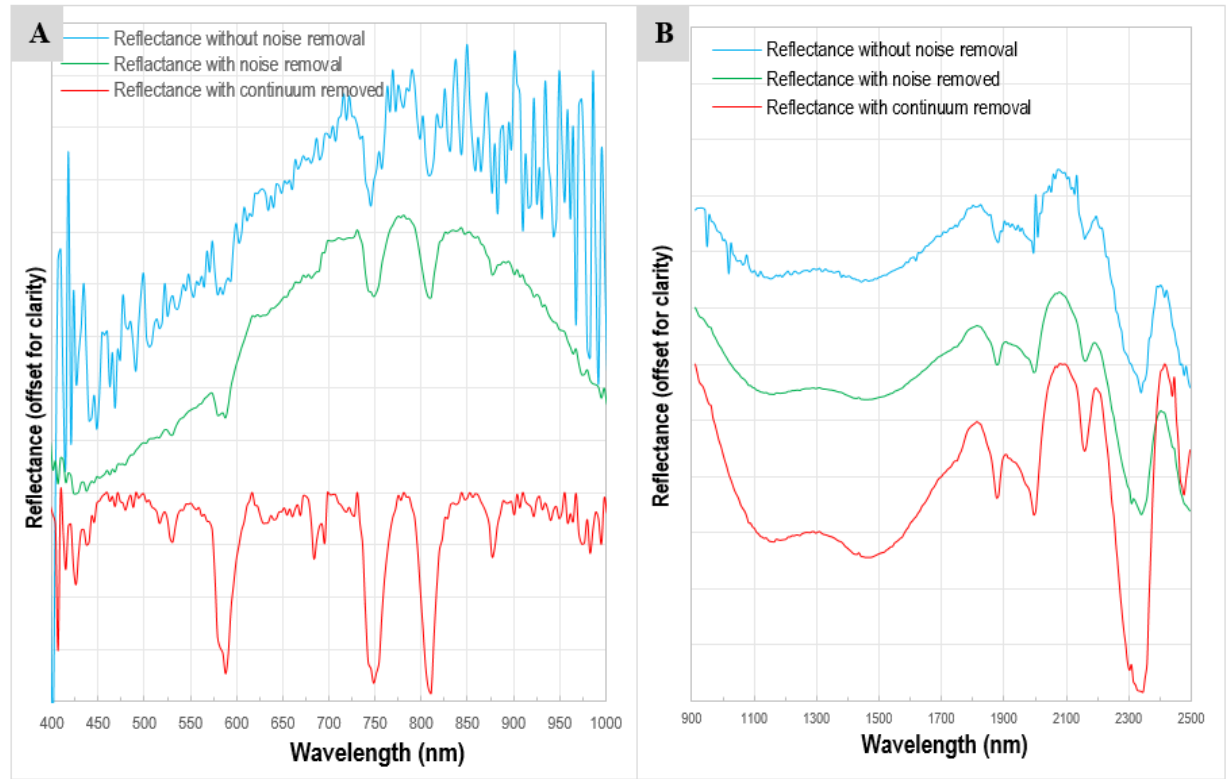
Figure 8. ( A ) The reflectance spectrum taken from the VNIR image of the SP7 sample. Noise-free VNIR spectra (green profile) are obtained through MNF rotation and FFT filter application applied on the noisy VNIR spectra (blue profile) that makes the noise-suppressed Nd absorption features prominent at 525, 587.5, 680, 745.91, 810.25 nm. Continuum-removed spectrum (red profile) shows the actual depth and the area of the Nd absorption feature at these absorption features. ( B ) The reflectance spectrum taken from the SWIR image of the same sample. No features of Sm, Pr, or Eu were observed in the SWIR part of the spectrum, however, the calcite absorption features are conspicuous. The valley between 1100 and 1500 nm is probably due to the Fe content.